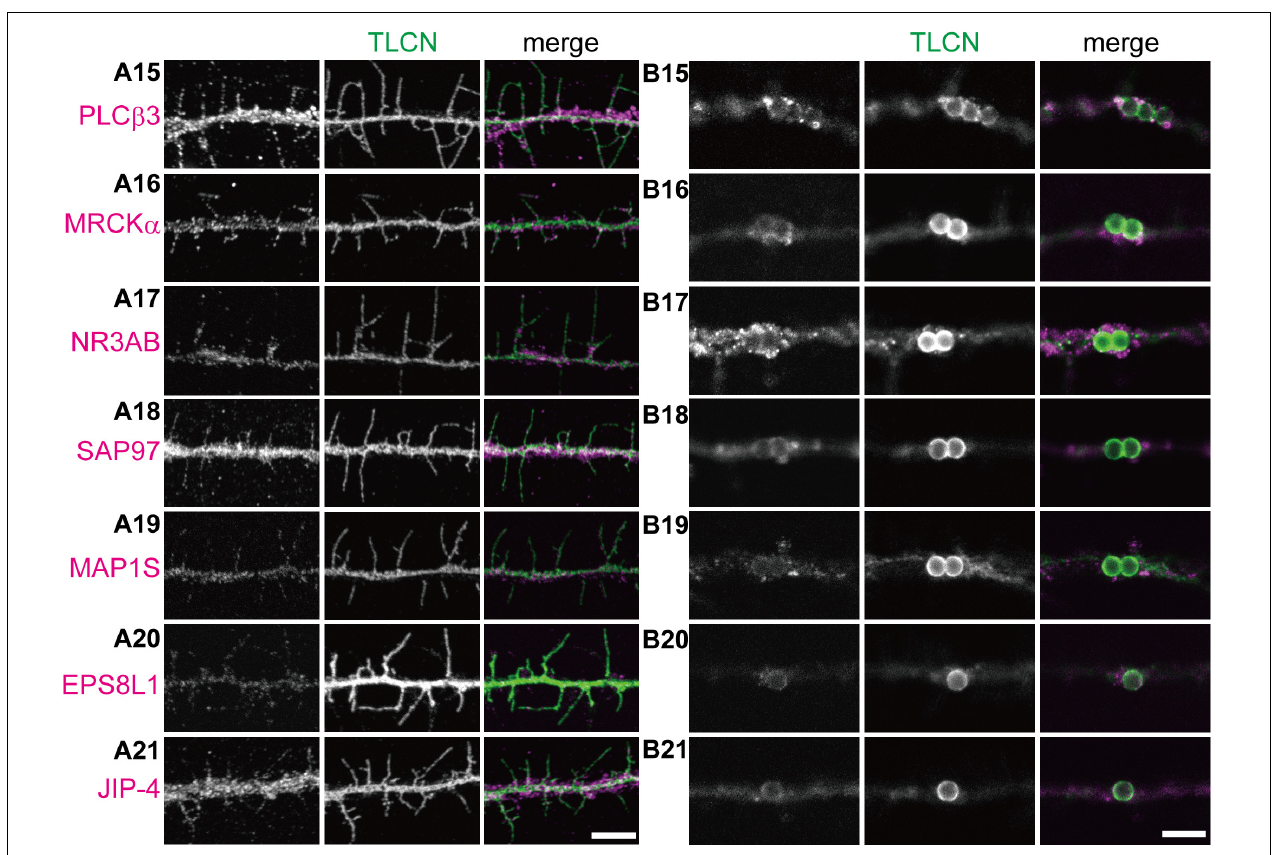
FIGURE 4 | Validation of the identified proteins in dendritic filopodia. (A,B) Localization of the identified proteins in dendritic filopodia (A1–A21) and phagocytic cups (B1–B21) at 14 DIV hippocampal neurons. The cultured neurons were immunostained with anti-TLCN antibody and specific antibodies against G α o (A1,B1) , Na + /K + ATPase α 3 (A2,B2) , EFA6D (A3,B3 ), spectrin (A4,B4) , septin7 (A5,B5) , myosin VA (A6,B6) , G α q (A7,B7) , G β 2 (A8,B8) , eEF1 γ (A9,B9) , ribosomal protein S16 (A10,B10) , CaMKII α (A11,B11) , CD98hc (A12,B12) , EFA6C (A13,B13) , BAIAP2L1 (A14,B14) , PLC β 3 (A15,B15) , MRCK α (A16,B16) , NR3A/B (GluN3A/B) (A17,B17) , SAP97 (SLC3A2) (A18,B18) , MAP1S (A19,B19) , EPS8L1 (A20,B20) , and JIP-4 (SPAG9) (A21,B21) . In merged images, the identified proteins and TLCN are shown in magenta and green, respectively. Single plane of images focused on dendritic filopodia (A1–A21) and center of microbeads (B1–B21) were acquired using a confocal microscopy. Scale bars, 5 µ m in (A14,A21,B14,B21)